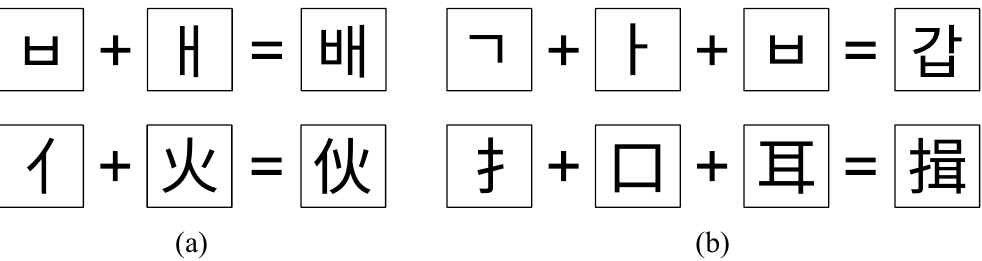
Figure 1. Example of combination characters. ( a ) example of a combination of two components, ( b ) example of a combination of three components. Hangul has 11,172 syllables in a combination of 2 or 3 components, and there are over 50,000 combinations in Chinese